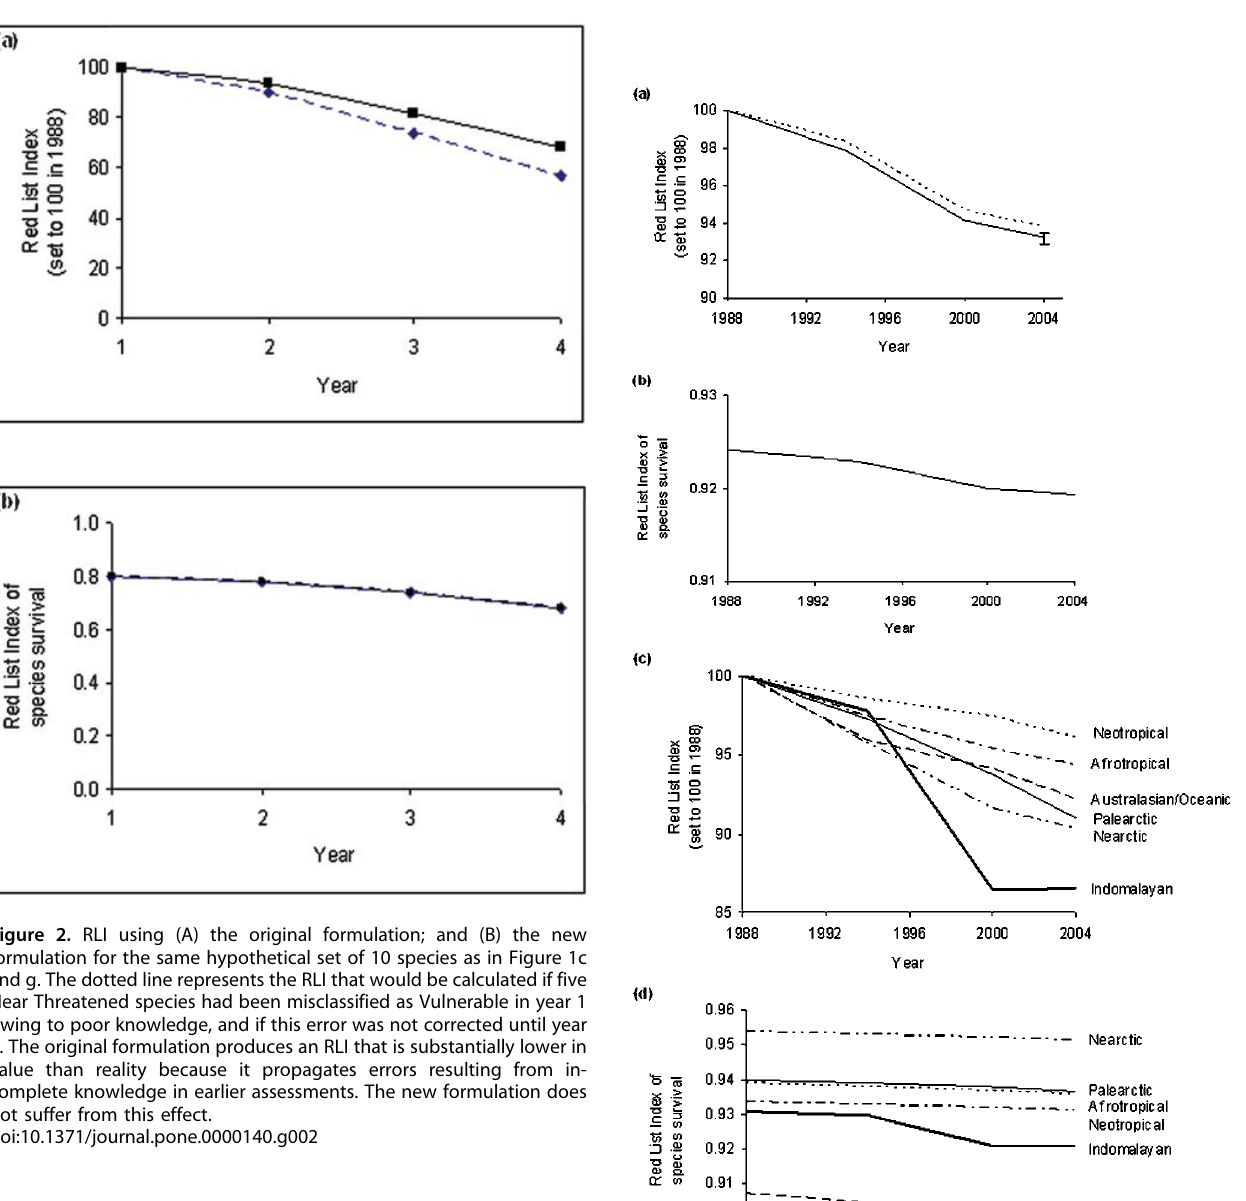
value indicates how far the set of species has moved overall towards extinction. Thus the revised RLI allows comparisons between sets of species in both their overall level of extinction risk (i.e. how threatened they are on average), and in the rate at which this changes over time. This represents an advantage over the original formula, in which RLIs for different sets of species are all set to 100 in the baseline year, masking any overall differences in extinction risk. Figure 3 shows the revised RLI using the original and revised formulas for all birds for 1988–2004, and for birds in different biogeographic realms during the same period. The latter figures highlight the difference between the formulas when comparing multiple sets of species. Under the original formula, birds in the Nearctic and Indomalayan realms appeared to have undergone the largest proportional deterioration in status. The RLI using the revised formula also highlights the plight of Indomalayan species, but shows that Nearctic species are the least threatened on average, and that those in the Australasian/Oceanic realms are also of particular concern.